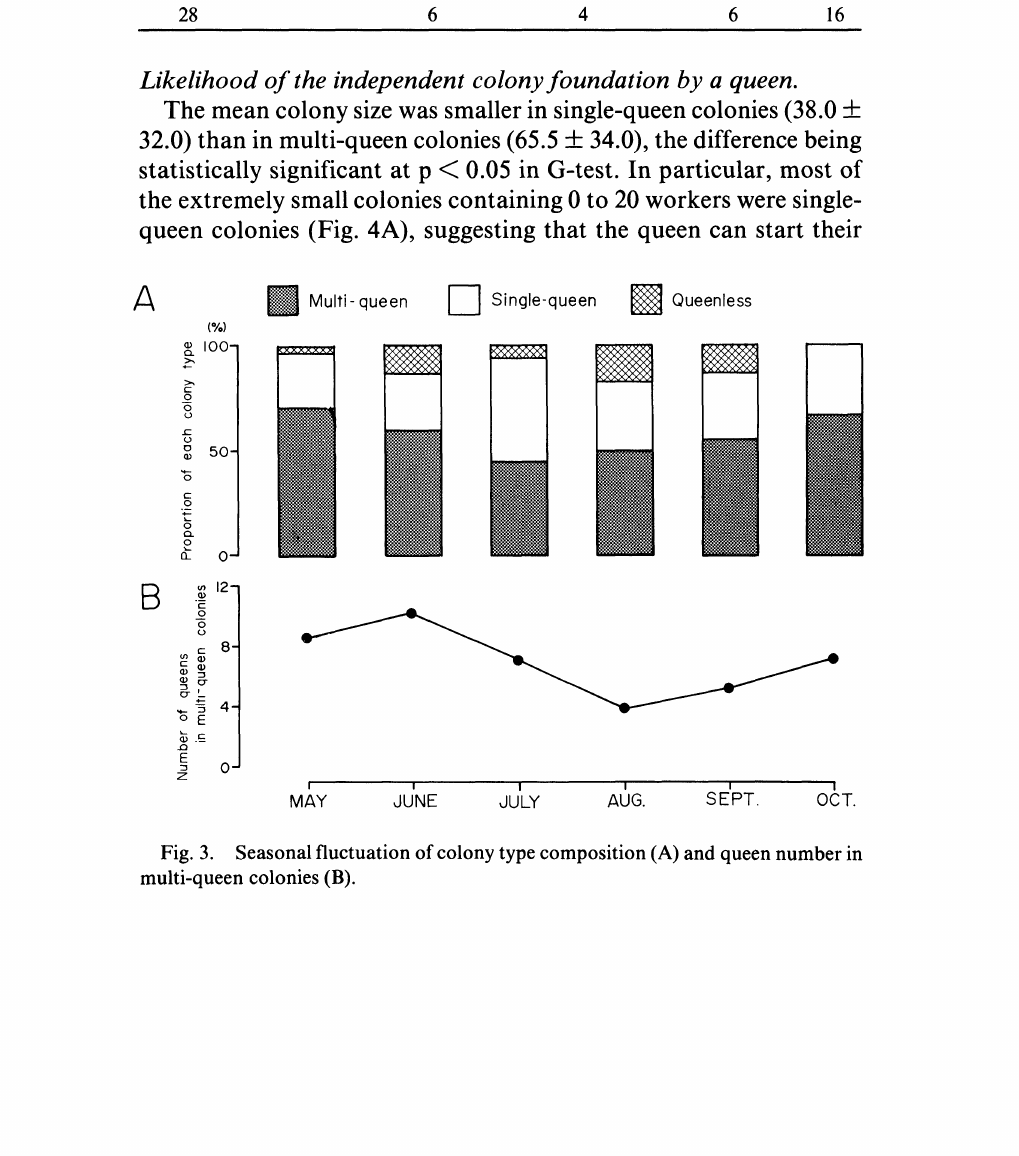
Fig. 3. Seasonal fluctuation of colony type composition (A) and queen number in multi-queen colonies